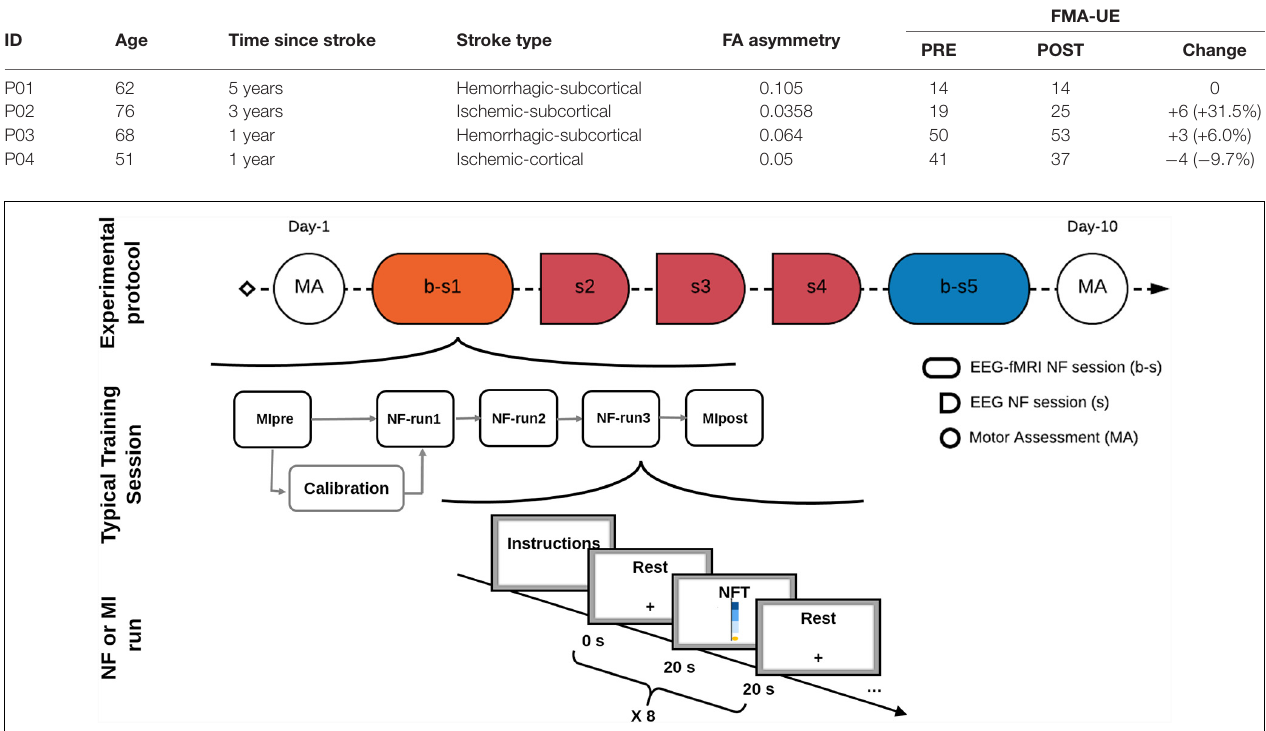
FIGURE 1 | Experimental protocol of multisession Neurofeedback (NF) training procedure. Motor assessment (MA) and NF training sessions timeline is shown in the first row (bimodal EEG-FMRI b-s1 and b-s5 and unimodal EEG s2, s3 and s4). The second row is a schematic of the training protocol that was repeated at